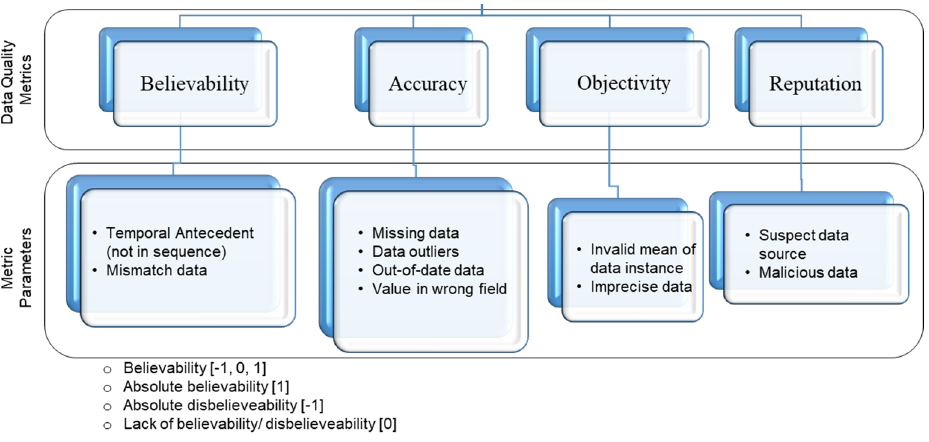
Figure 5. Intrinsic data quality metric parameters.